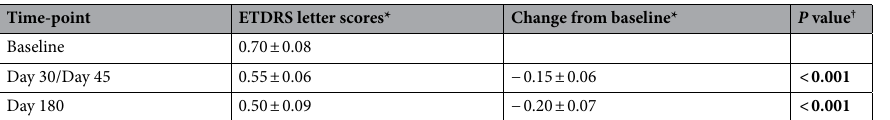
Table 2. Change of best-corrected visual acuity over the 6-month follow-up period. ETDRS early treatment diabetic retinopathy study. *Data reported as mean ± standard deviation. † p -values are obtained by generalized estimating equation regression models; statistically significant p-values are shown in